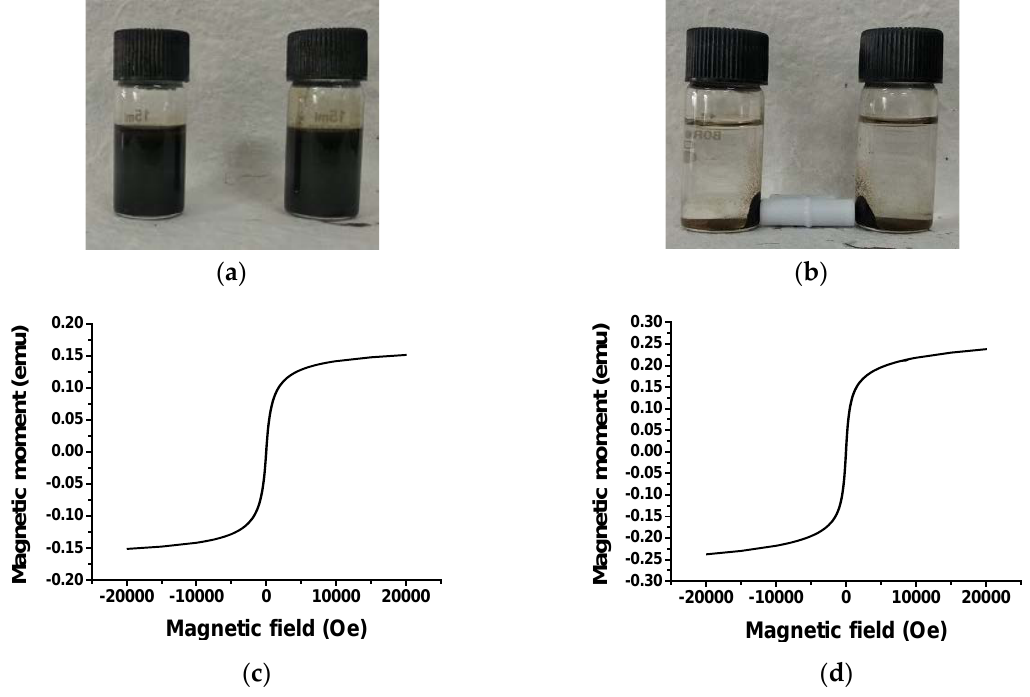
Figure 8. Respective MNPs solutions; ( a ) before separation; ( b ) after using a magnetic bar. VSM analysis